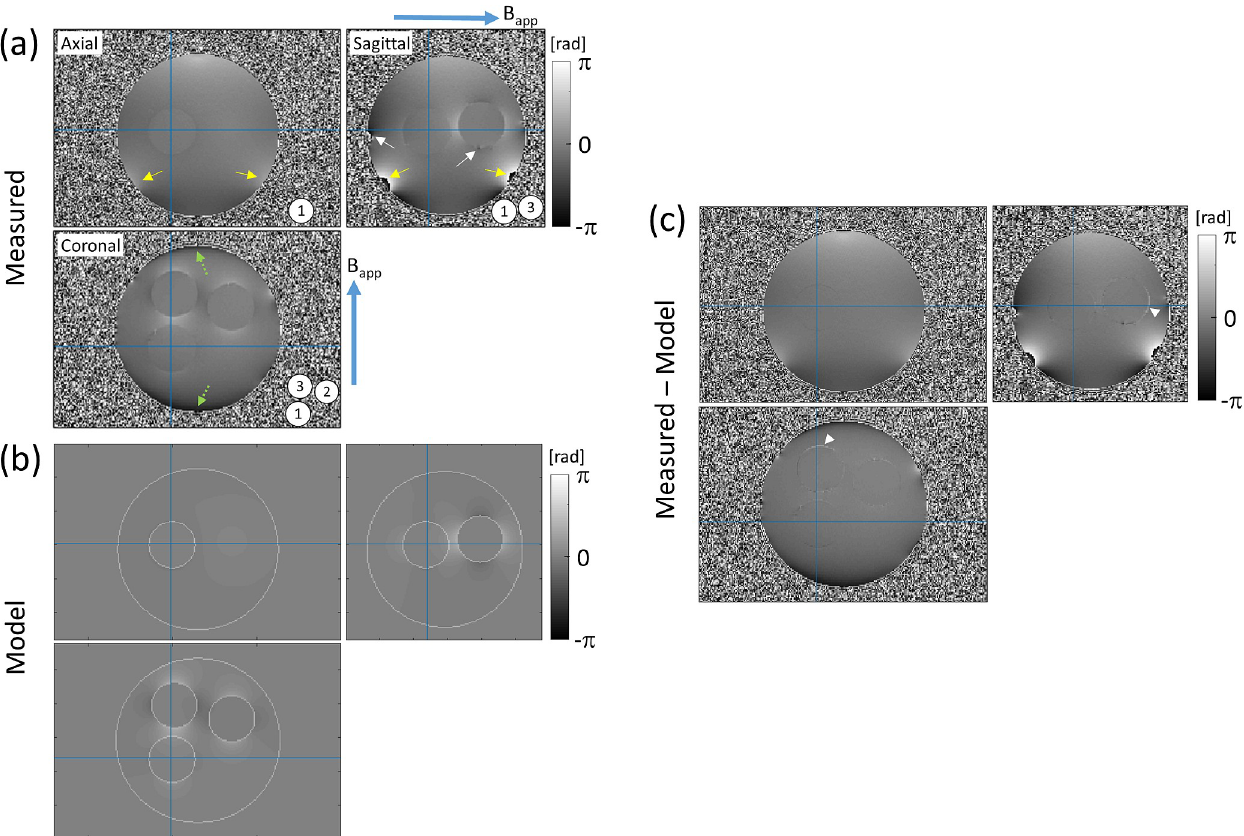
Fig 5. Measured vs model phase maps. (a) Measured phase. Phase variations due to air bubbles (white arrows), phantom stand (yellow arrows), and imperfect shimming (green dotted arrows) are visible. Spherical inclusions (1 – 3) produce dipolar field patterns consistent with the main field (B app ) direction (blue arrows). (b) Dipolar model phase for inclusion susceptibilities 0.1, 0.2, 0.3 ppm. (c) Phase difference, showing good agreement between model and measurement. White arrowheads indicate error due to model boundary